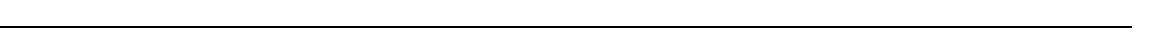
Fig. 4 Photoelectrochemical water splitting with the Au@Nb@H x K 1 − x NbO 3 NPP photoelectrode. a Current-potential characteristics of the Au@Nb@H x K 1 − x NbO 3 photoelectrode in 0.5 M Na 2 SO 4 solution (pH 6.8) under chopped (orange line) and continuous (green dashed line) AM 1.5G simulated sunlight illumination. The dark current is plotted alongside (dark dotted line). b , c Wavelength-dependent photocurrent-time plots (baseline subtracted) of a H x K 1 − x NbO 3 NS ( b ) and a Au@Nb@H x K 1 − x NbO 3 NPP photoelectrodes ( c ) under irradiation of AM 1.5G simulated sunlight (gray line) equipped with different long-pass fi lters (colored solid lines) in the presence of an anodic bias of 1 V (vs. Ag/AgCl). Absorption spectra of the H x K 1 − x NbO 3 NSs (black dashed line in b ) and AM 1.5G simulated sunlight ( fi lled squares in c ) illumination after passing a UV cutoff fi lter (blue dashed line in c ) or different colored glass fi lters (green, red, brown, and black dashed line in c ) are plotted alongside for comparison. b Photocurrent-time plot (baseline subtracted) of the H x K 1 − x NbO 3 NS photoelectrode under integral red-NIR illumination in the presence of an anodic bias of 1 V (vs. Ag/AgCl). d Fluence-dependent photocurrent-time plots (baseline subtracted) of the Au@Nb@H x K 1 − x NbO 3 NPP photoelectrode. e Postulated charge transfer on the Au@Nb@H x K 1 − x NbO 3 NPP heterojunction starts with the photoabsorption process. f I in as a function of simulated sunlight intensity of the Au@Nb@H x K 1 − x NbO 3 NPP photoelectrode. g Postulated either simulated sunlight (gray line) or integral VIS-NIR light (blue line) for the H x K 1 − x NbO 3 NS photoelectrode. h Fluence-dependent photocurrent-time plots (baseline subtracted) of the H x K 1 − x NbO 3 NS photoelectrode. i Schematic illustration of the 3D metal-semiconductor heterojunction of the presence and absence of AM 1.5G simulated sunlight. The difference in absorbance ( Δ A) between the aforementioned two conditions is plotted